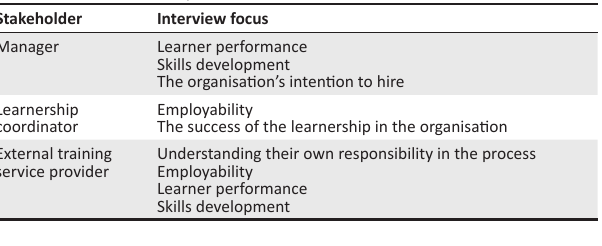
TABLE 2: Interview focus per